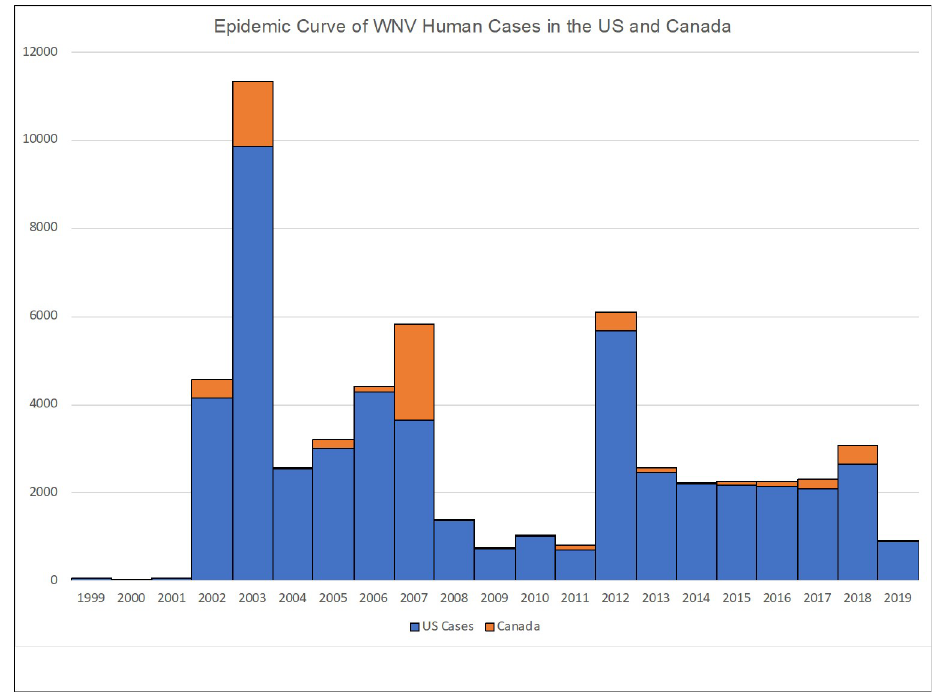
Fig 1. Epidemic curve of WNV human cases in the US and Canada, 1999–2019. WNV, West Nile virus.